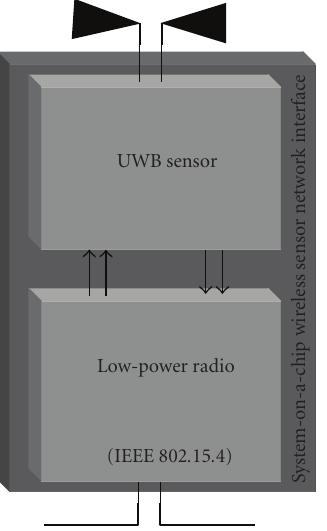
Figure 3: Future perspective: integration on a single silicon chip of the overall wearable wireless interface on a single silicon chip.